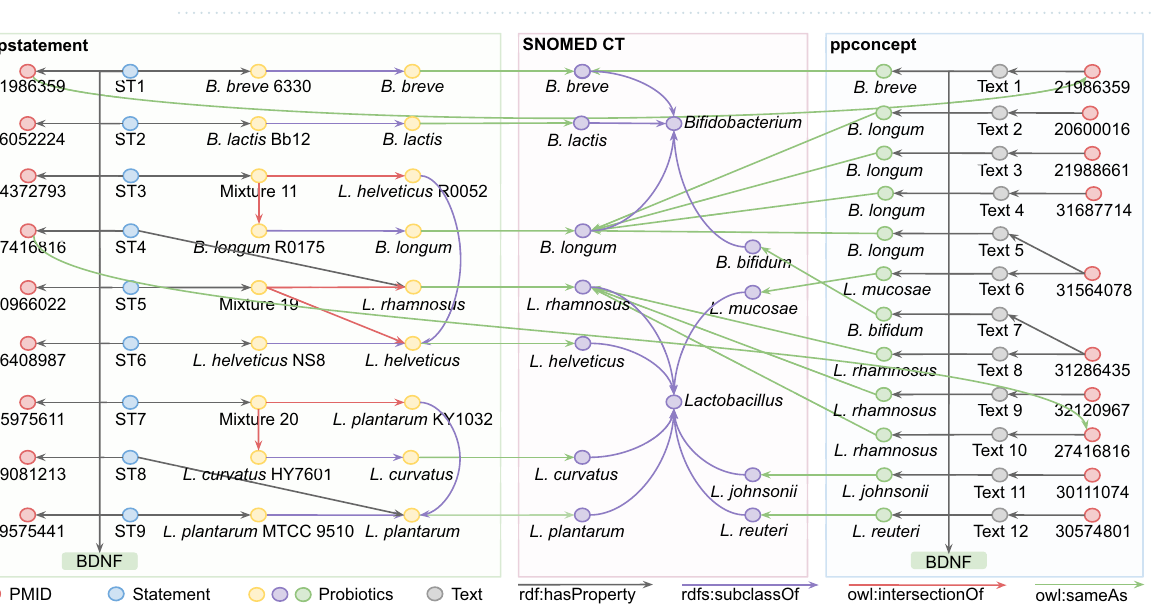
Figure 8. The retrieved paper-texts that contain children concepts of Microorganisms and Finding related to sleep by query case 2, with the code shown in SI Listing 2. Yellow rectangles: PMIDs; green rectangles: annotated concepts; blue rectangles: free texts. For clarity of presentation, long sentences were simplified and probiotic strains were abbreviated.